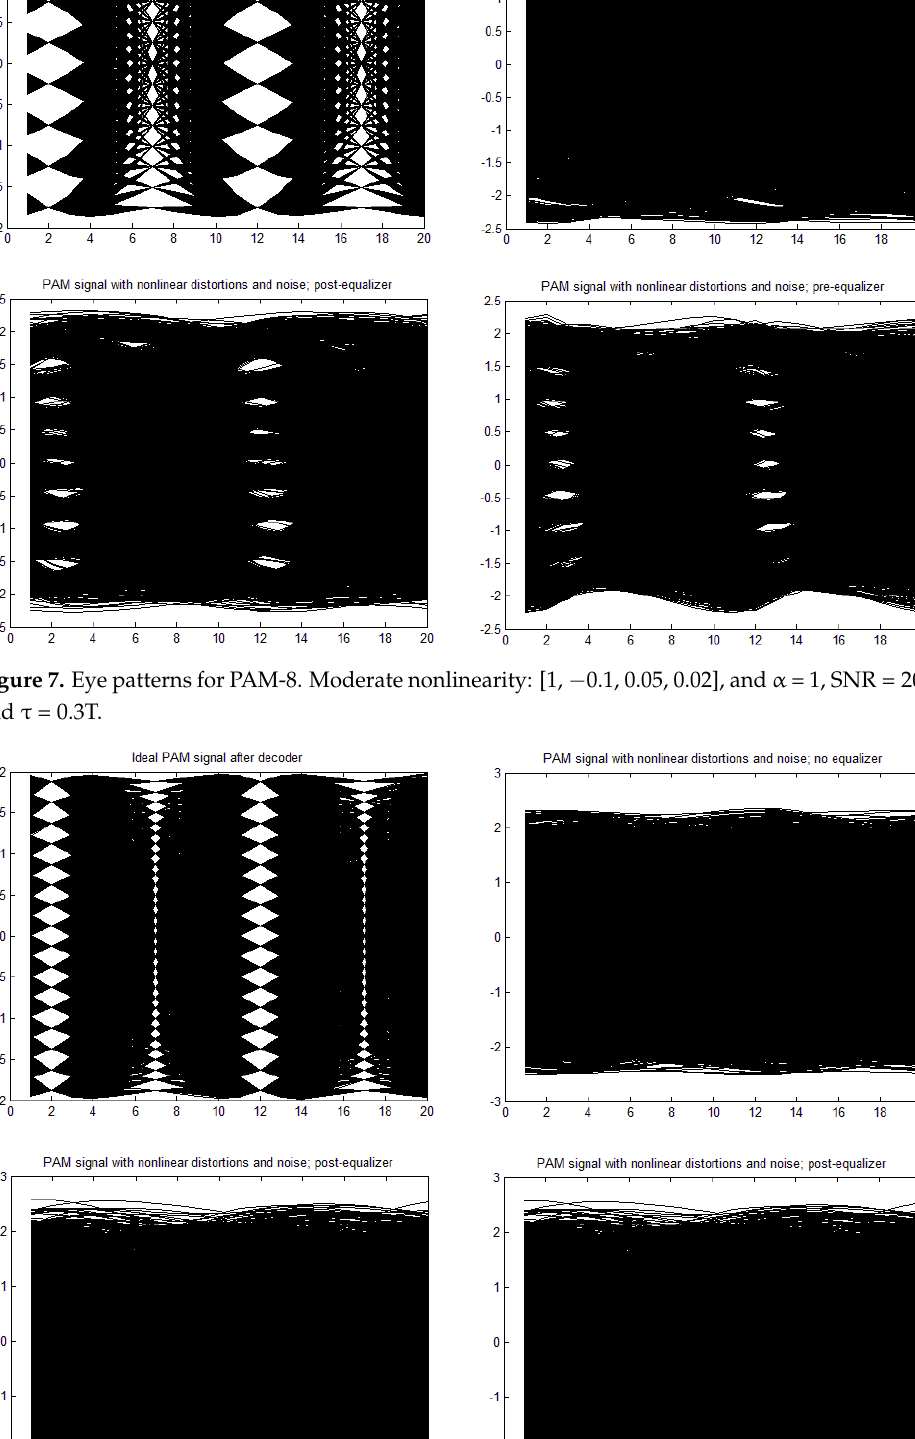
Figure 8. Eye patterns for PAM-16. Moderate nonlinearity: [1, − 0.1, 0.05, 0.02], and α = 1, SNR = 20 dB, and τ = 0.3T.